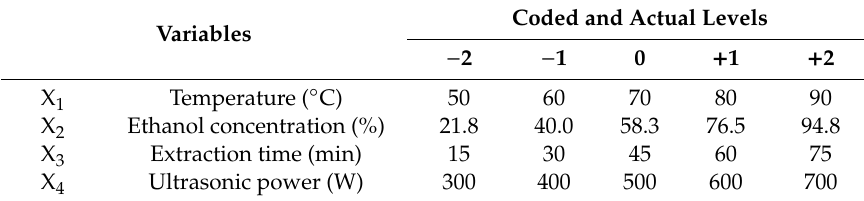
Table 1. Independent variables and their coded and actual levels for central composite design (CCD). Coded and Actual Levels Variables − 2 − 1 0 + 1 +